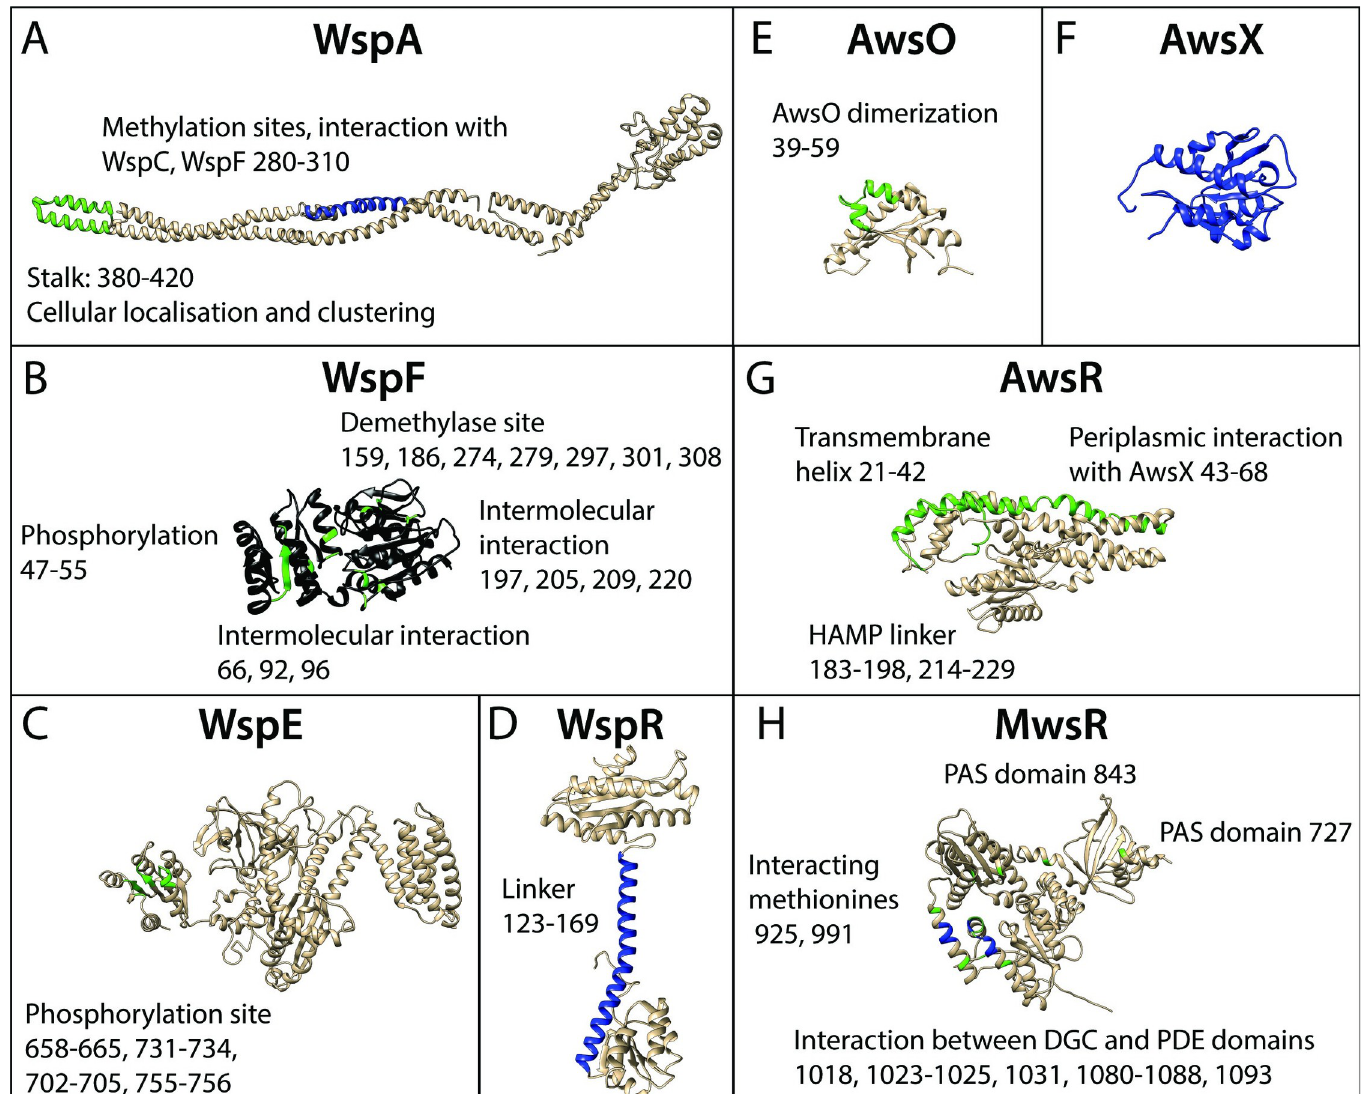
Fig 2. Predicted mutational targets and proposed molecular effects. Black represents any inactivating mutation including frame shifts, blue represents in frame inactivating mutations, green represents amino acid substitutions. Numbers refer to amino acid residue numbers in Pf-5. ( A ) WspA–amino acid substitutions are expected at the tip of the stalk and in-frame deletion of methylation sites. ( B ) WspF–any inactivating mutation is predicted, amino acid substitutions are predicted only in areas where they disrupt intermolecular interactions. ( C ) WspE–amino acid substitutions are predicted near the phosphorylation site. ( D ) WspR–small in frame deletion and amino acid substitutions in the linker is predicted to cause constitutive activation. ( E ) AwsO–amino acid substitutions disrupting AwsO dimerization is predicted to lead to increased binding to AwsX without the presence of an activating signal. ( F ) AwsX–any inactivating mutation that keep the reading frame intact and do not interfere with expression of downstream AwsR is predicted. ( G ) AwsR–amino acid substitutions in the periplasmic region or transmembrane helix that disrupt the interaction with AwsX or to the HAMP linker is predicted. ( H ) MwsR–mutations are predicted in the interface between the DGC and phosphodiesterase domains and in the most C- terminal of the PAS domains resulting in constitutive